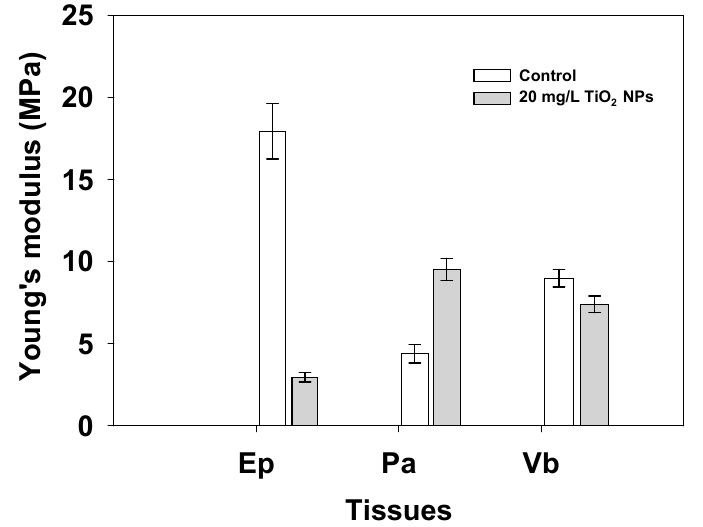
Figure 9. Young’s Modulus of the tomato root control and the root exposed to 20 mg/L of TiO 2 NPs for Ep, Pa, Vb. Bars show standard error.